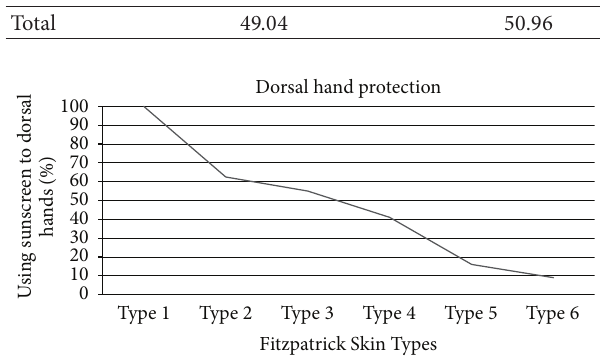
Figure 1: UVR dorsal hand protection in relation to Fitzpatrick Skin